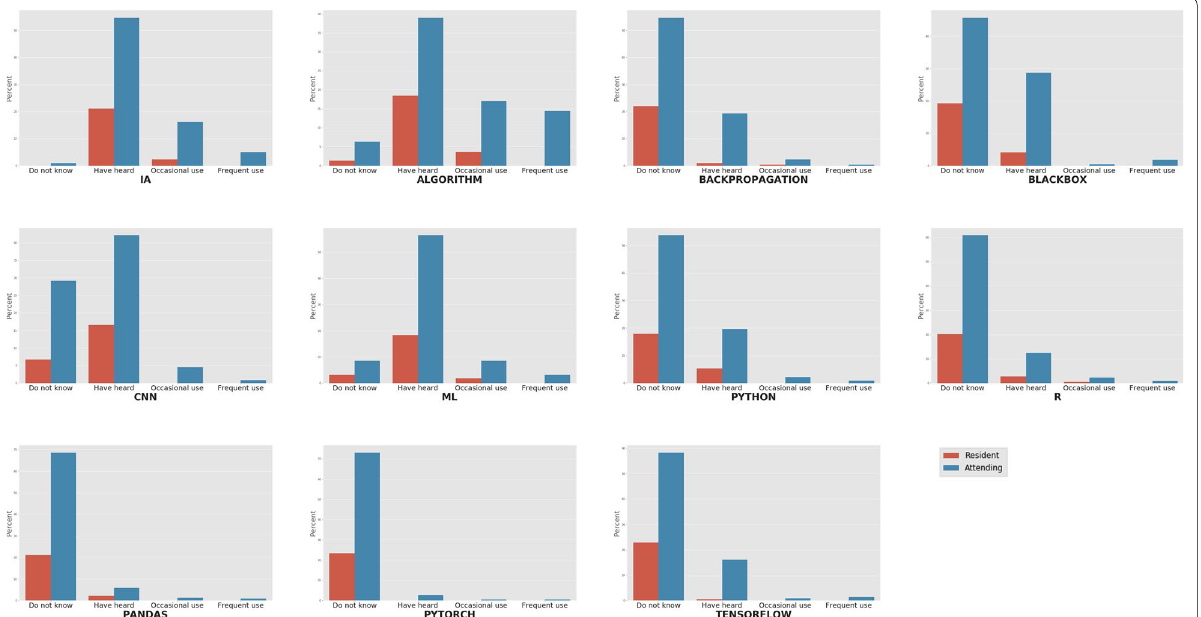
Fig. 1 Level of knowledge or usage of the different terms and technologies. Responses are divided into residents (red) and attending physicians (blue). The y ‑axis shows the percentage of answers for each group